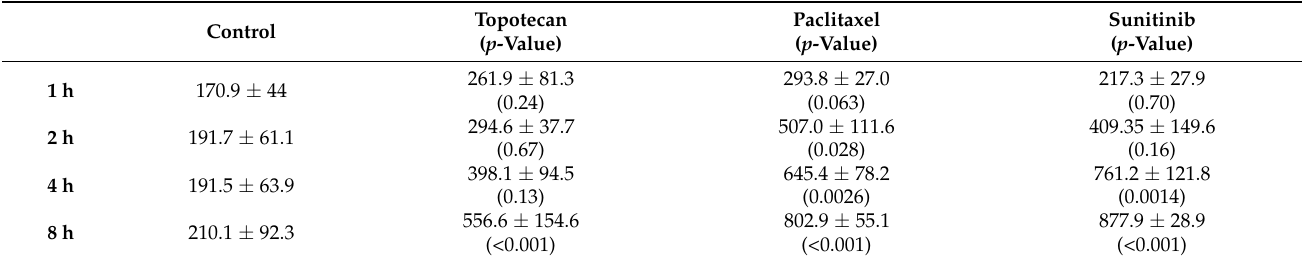
Table 1. Miniature 2-color microscopy (M-2CFM) of propidium iodide (PI) at drug and control sites. Mean and standard error of the mean (SEM) are reported in arbitrary signal intensity units (aiu) obtained at each time point for each drug/control site. p -values indicate comparison between signal intensities at each drug site compared to Control ( p < 0.05 was used as a measure of significance).